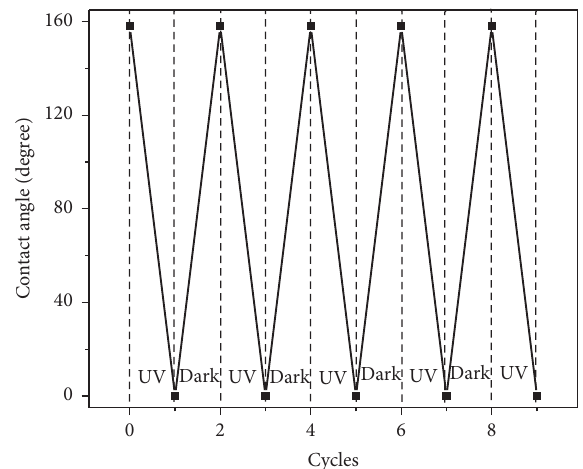
Figure 2: XRD patterns of the as-grown ZnO samples. (a) ZnO nanorod arrays. (b) ZnO nanoflakes.